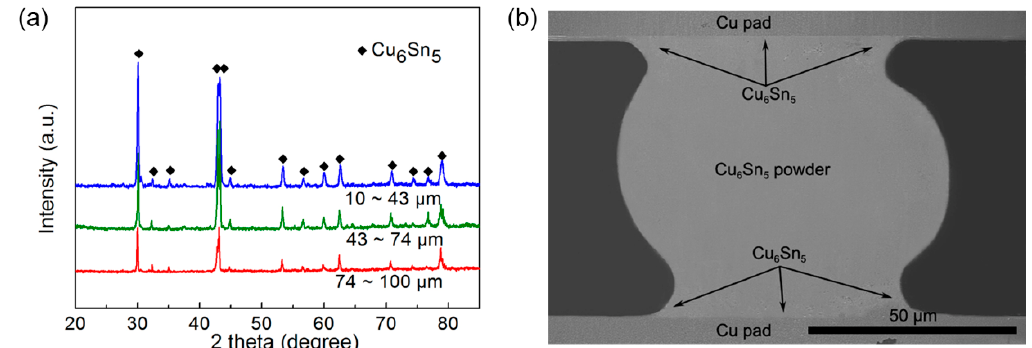
Figure 9. ( a ) XRD patterns of atomized powders as a function of power size after heat treatment at 300 °C for 4 h; ( b ) interconnection application of the Cu 6 Sn 5 intermetallic powder.